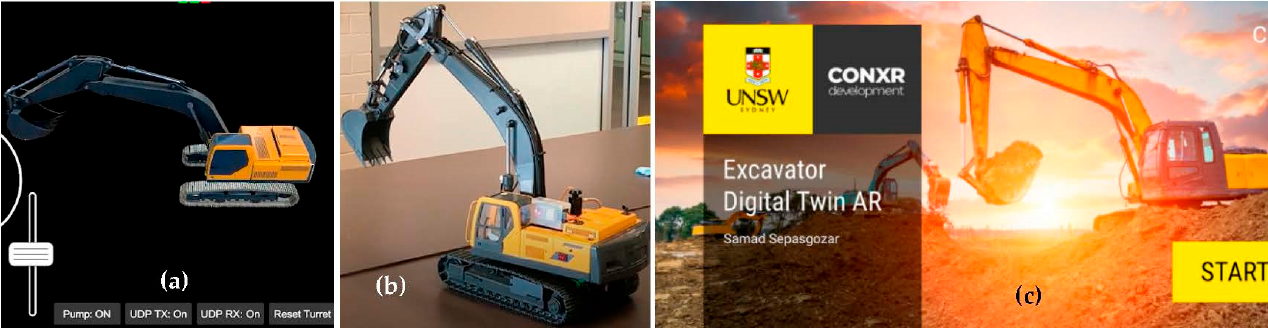
Figure 9. Digital and physical objectives in outdoor experimentation. ( a ) augmented model; ( b ) physical excavator model; ( c ) the DT application entrance.